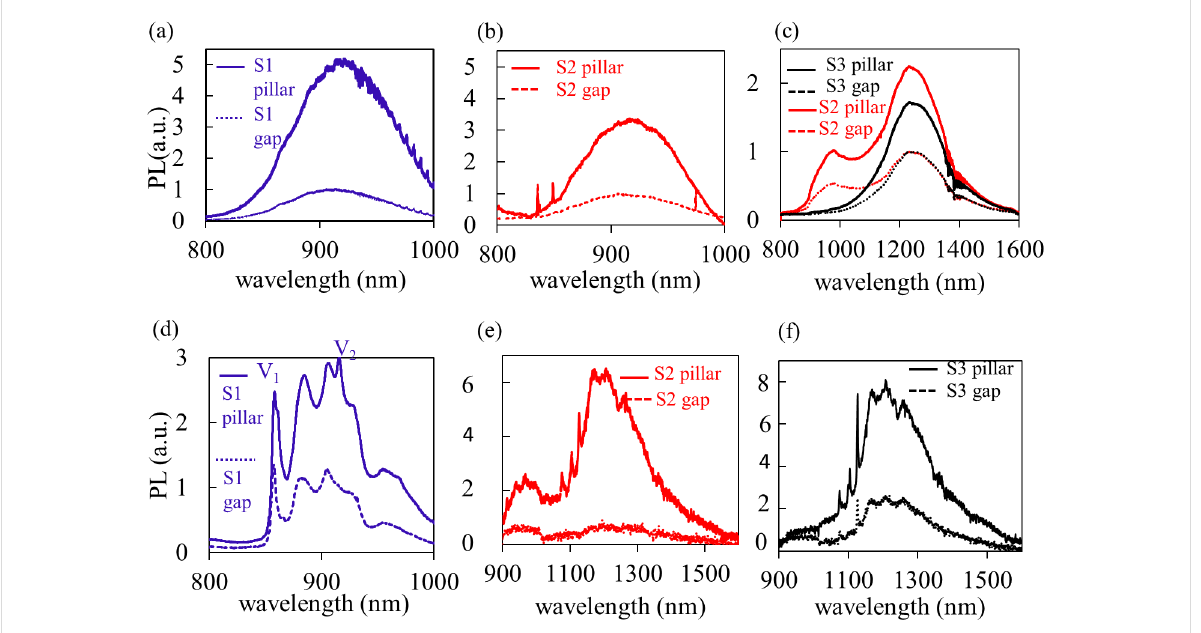
Figure 2: (a–c) Room-temperature PL spectra of the pillars and the gap area (lower dashed curves) for samples S1–S3 excited by a 785 nm CW laser. The PL curves are normalized to the maximum of the gap emission to show the enhancement. The red PL spectra in (c) refer to sample 2 and show the formation of an additional emission other than V Si with a peak at ca. 1300 nm. (d–f) Low-temperature (12 K) PL spectra of the pillars and gaps (lower dashed curve) of samples S1–S3 excited with 100 W/cm 2 671 nm CW laser. In (d) the V1 and V2 lines [30] of V Si are visible and the PL curves are normalized to the V2 line in the gap region. In (e) and (f), the PL1, PL2, and PL3 lines [34] of V Si V C are clearly seen for the pillars, and the PL curves are not normalized.